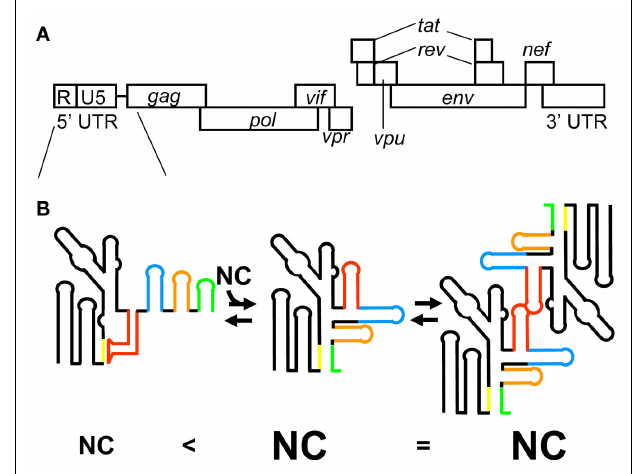
FIGURE 3 | (A) Genomic organization of HIV-1. (B) The latest model for HIV-1 genome packaging. Conformational change of RNA in the 5 (cid:2) leader region regulates genome dimerization and genome packaging.The stem-loop structure of AUG causes sequestering of DIS via long range interaction with the residues of U5, resulting in the inhibition of HIV-1 genome dimerization (left). In this conformation of the 5 (cid:2) leader RNA, a small number of NCs are capable of binding the 5 (cid:2) leader RNA. In contrast, the interaction of AUG with U5 residues promotes genome dimerization via exposure of DIS (center). In this conformation of the 5 (cid:2) leader RNA, a greater number of NCs are capable of binding the 5 (cid:2) leader RNA.The different RNA elements in the 5 (cid:2) leader region are color coded: DIS (red), SD (blue), Ψ (orange), and AUG